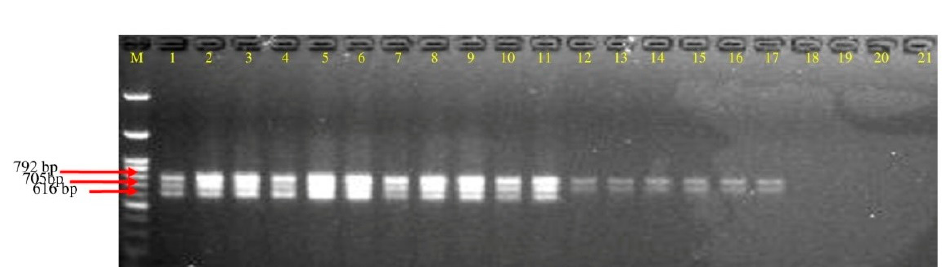
Figure 4. Detection Bacillus species using multiplex- PCR based on polyketides genes i.e., difficidin, macrolactin and bacillaene of Bacillus amplified at 705 bp, 792 bp and 616 bp respectively. Lane M.